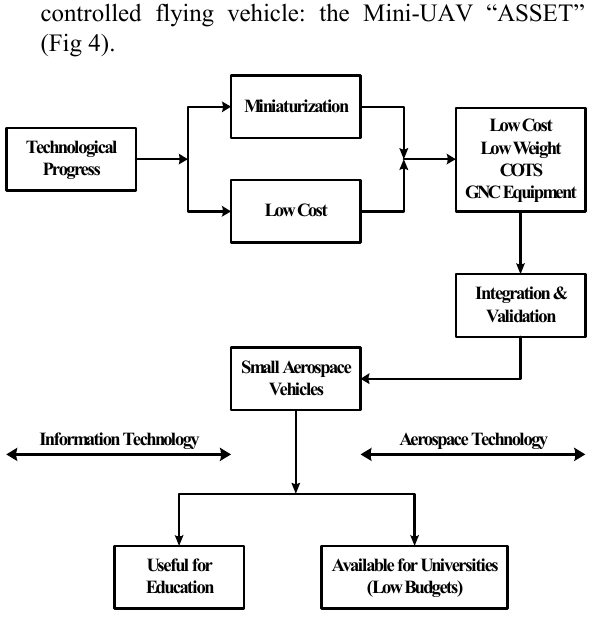
Fig 1. General considerations’ flow-chart